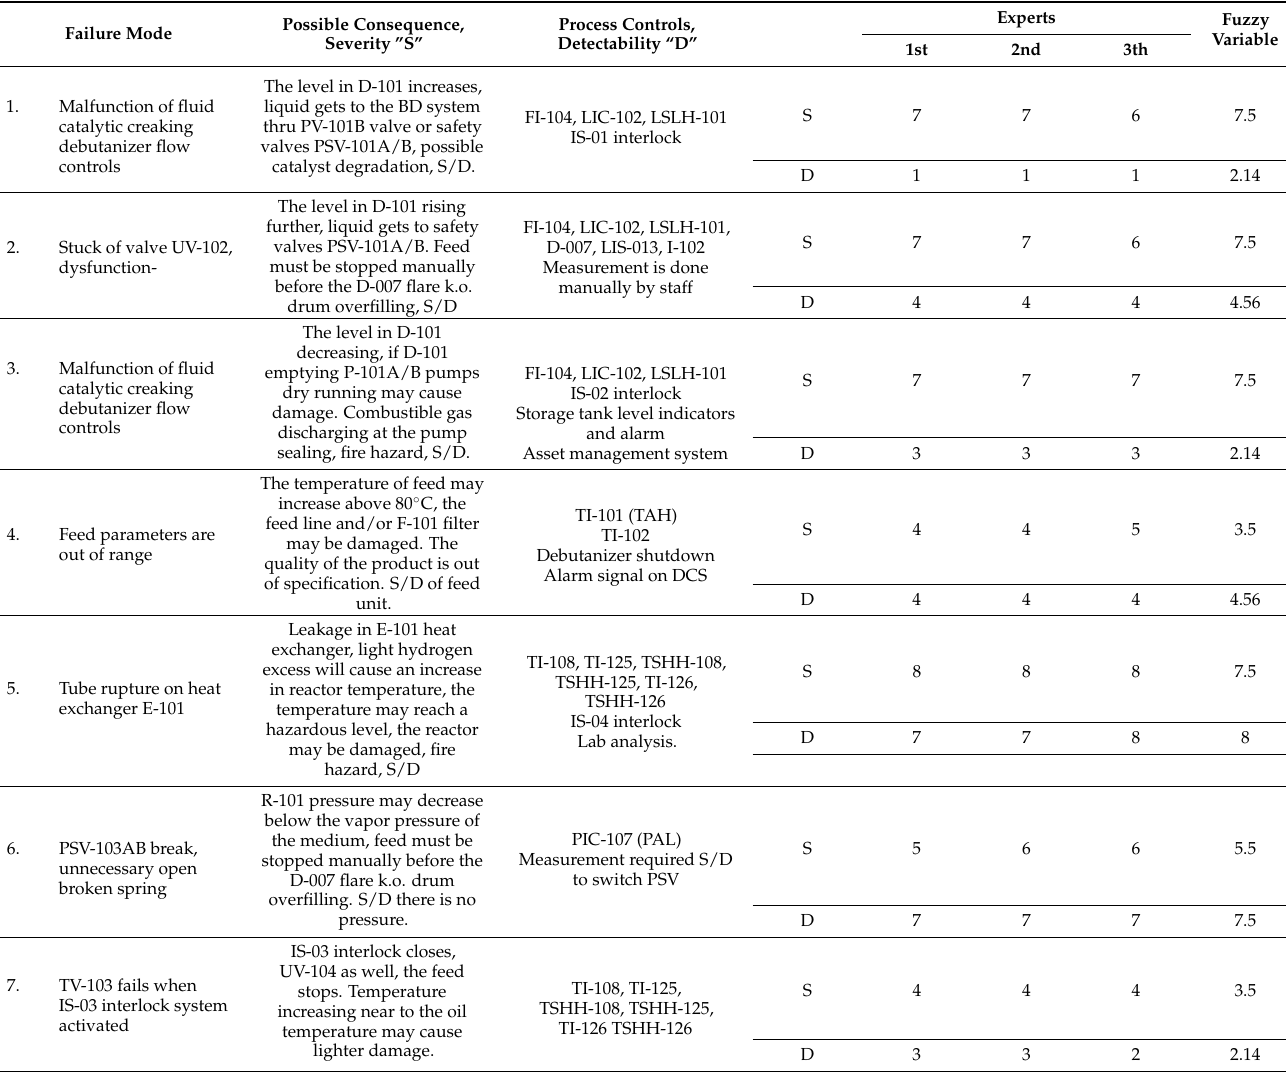
Table A2. The table contains subject matter experts’ assessment S and D for randomly selected failure modes and fuzzy calculation for HDS FCC